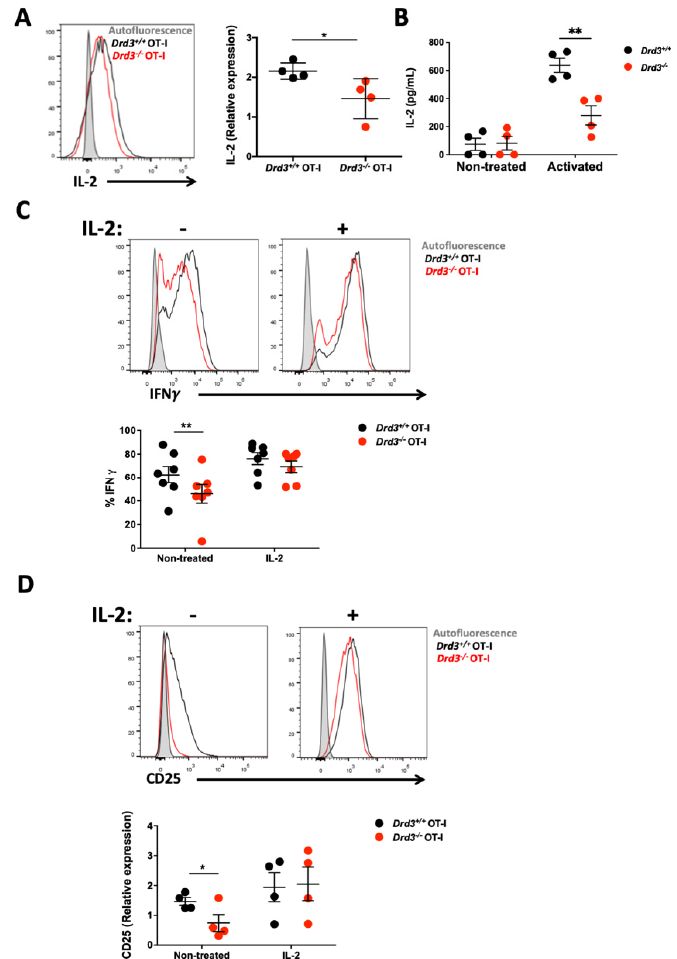
Figure 3. DRD3-signalling strengthens IFN- γ production by favouring IL-2 release. ( A ) Splenic CD8 + T-cells were isolated from Drd3 +/+ or Drd3 − / − OT-I male mice and stimulated with anti-CD3 and anti-CD28 Abs in the absence of exogenous IL-2 for 48 h. Subsequently, cells were cultured for an additional 48 h in the absence of anti-CD3 and anti-CD28 Abs. The pOT-I was added to the cultures for the last 6 h, and then IL-2 was evaluated by intracellular immunostaining followed by flow cytometry analysis. The left panel shows representative histograms. The right panel shows the quantification. Values are the MFI associated with IL-2 in the CD8 + ZAq − gate normalised to the value of IL-2 MFI obtained for non-stimulated OT-I cells. ( B ) Splenic CD8 + T-cells isolated from Drd3 +/+ or Drd3 − / − male mice were non-treated or activated with anti-CD3 and anti-CD28 Abs in the absence of exogenous IL-2 for 24 h, and the extent of IL-2 secretion into the supernatant was quantified by ELISA. Each symbol represents data obtained from an individual mouse. ( C , D ) Drd3 +/+ or Drd3 − / − OT-I CD8 + T-cells were activated with anti-CD3 and anti-CD28 Abs in the absence or the presence of exogenous IL-2 during 48 h. Cells were cultured for an additional 48 h in the absence of anti-CD3 and anti-CD28 Abs. The pOT-I was added to the cultures for the last 6 h, and the intracellular IFN γ production ( C ) and surface CD25 expression ( D ) were assessed by flow cytometry. ( C , D ) The top panels show representative histograms and the bottom panels the quantification of the percentage of IFN γ + cells ( C ) and the normalised MFI for CD25 ( D ) in the CD8 + ZAq − gate. The histograms associated with autofluorescence are shown as a reference in the top panels. ( A – D ) Each symbol represents data obtained from a different mouse. Data from four ( A , B , D ) or seven ( C ) independent experiments is shown. The mean ± SEM are depicted. *, p < 0.05; **, p < 0.01; by Student’s t -test ( A ) or two-way ANOVA followed by Tukey’s post hoc test ( B , C